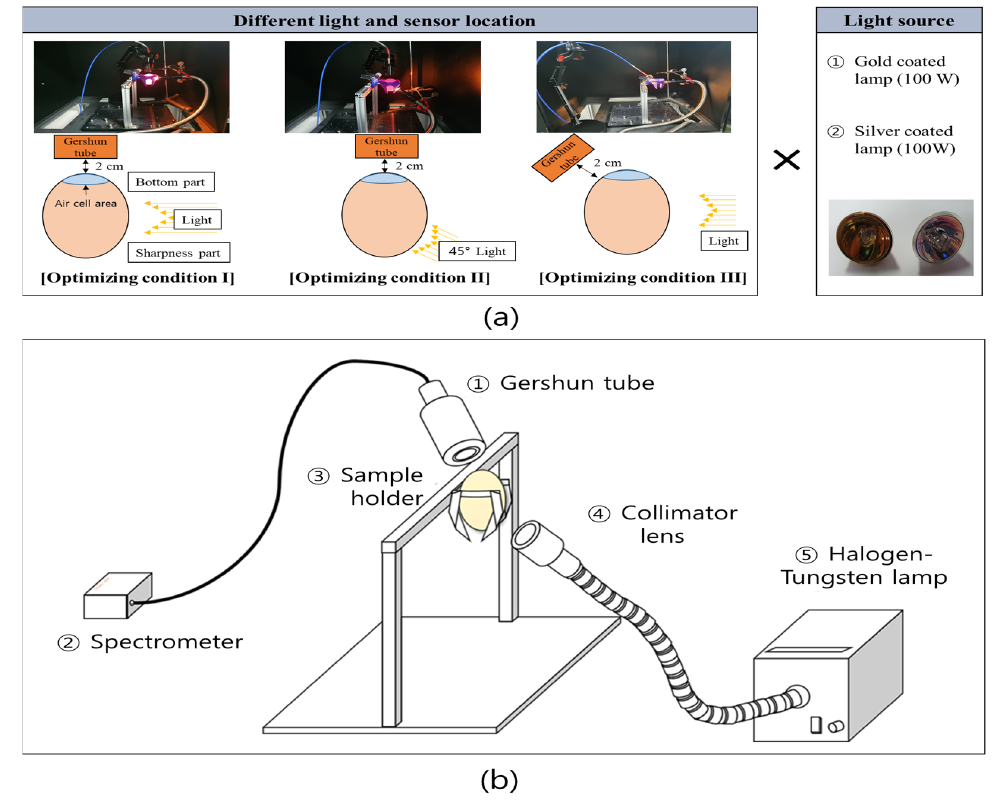
Figure 4. Experimental design schematic. ( a ) Each experimental condition schematic; ( b ) abnormal egg measurement system schematic.